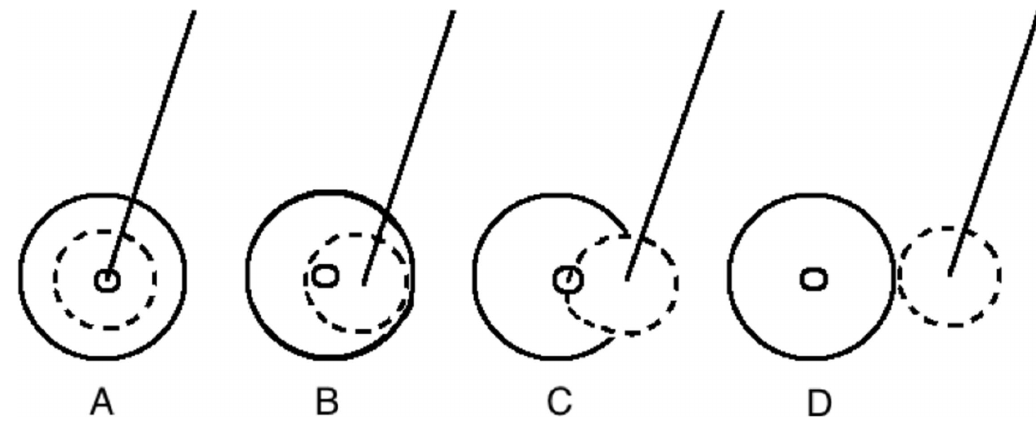
Fig 5. The ablation successcategories. A: In nidus, complete.B: In centre, complete.C: In centre, incomplete. D: Not in centre, incomplete.